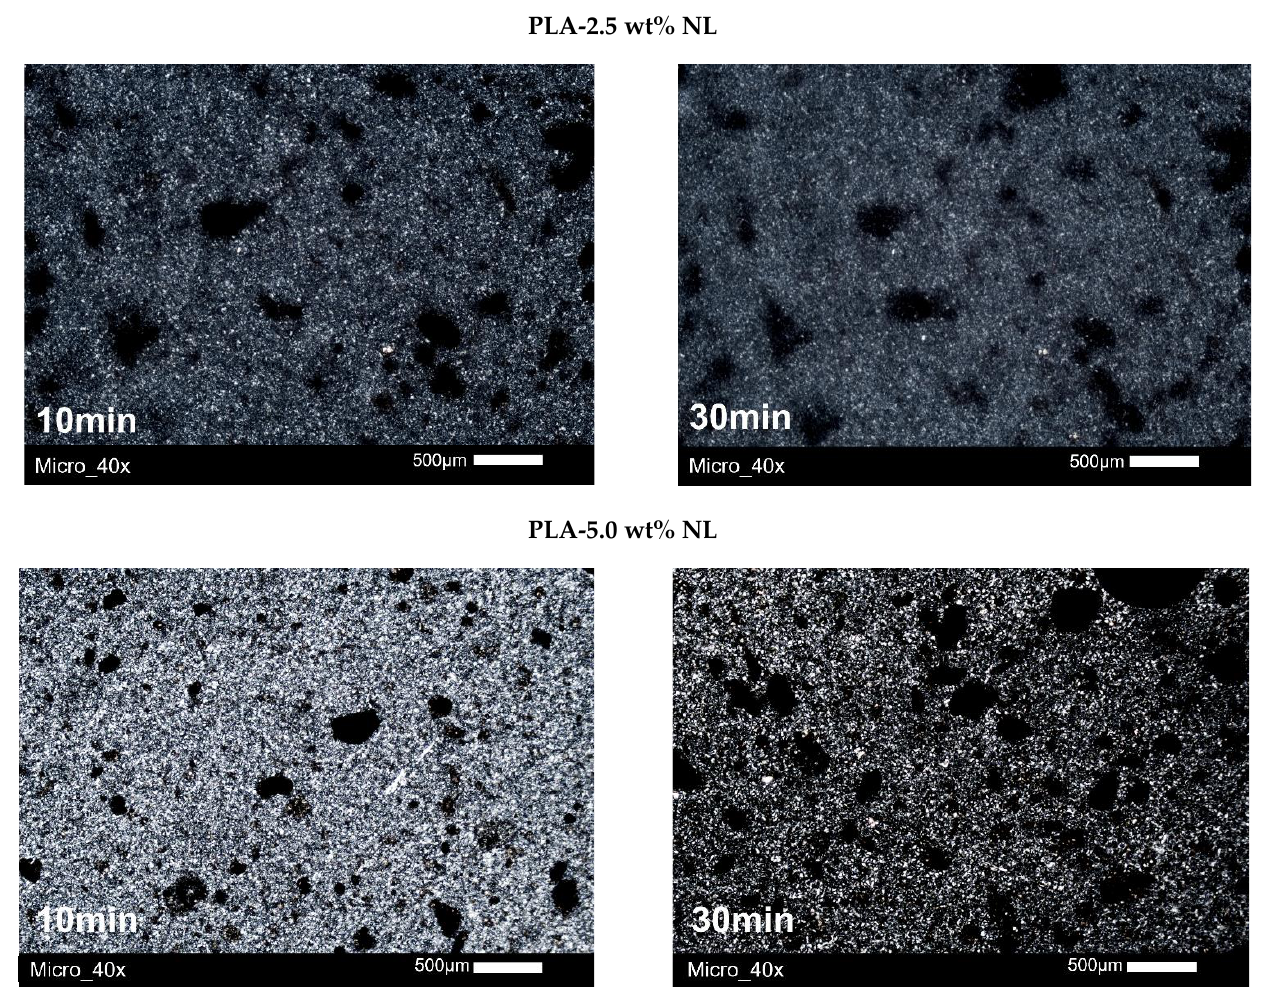
Figure 10. Microphotographs of neat PLA and PLA–nanolignin composites after annealing for 10 and 30 min using PLM.